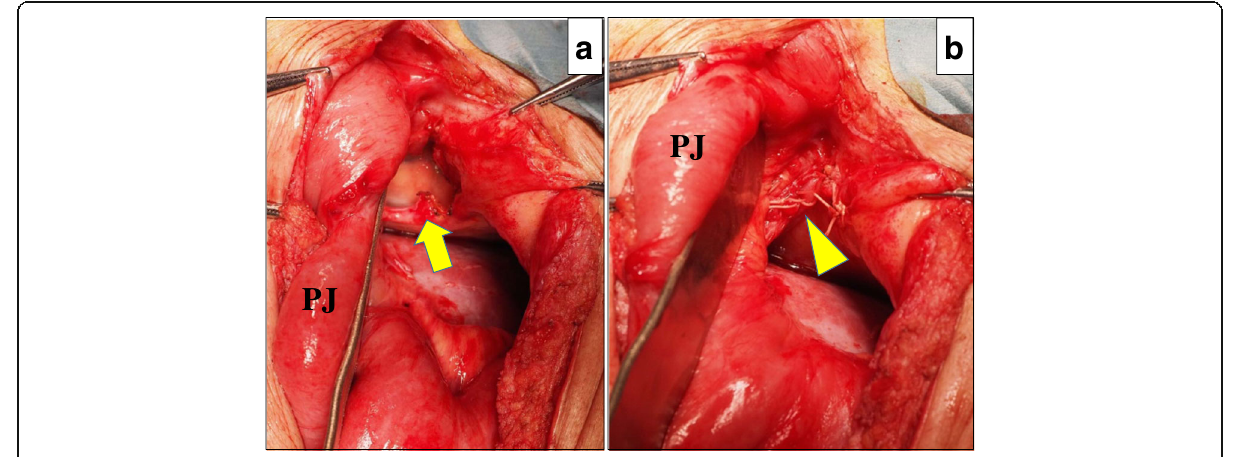
Fig. 4 Intraoperative photographs show a the hernia orifice (arrow) and b the primary suture line. PJ : pedicled